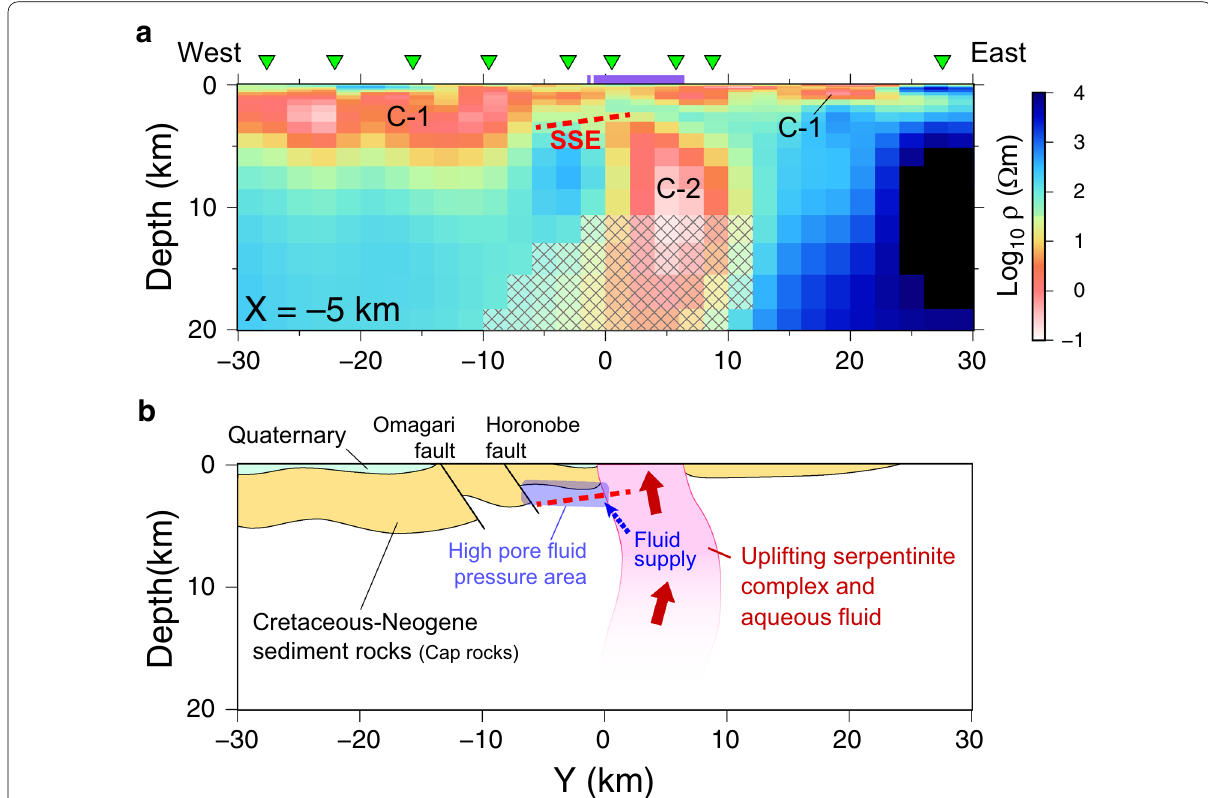
Fig. 5 a West–east cross-section at X – 5 km for the inverted model. The cross-hatched area shows the low-sensitivity area within the C-2 = anomaly. The red dashed line marks the SSE fault plane inferred by Ohzono et al. (2015). The other symbols are the same as in Fig. 3. b Geological interpretation of the inverted model at X – 5 km. The pink area with red arrows represents the uplifting serpentinite complex and associated = fluids, and includes the C-2 anomaly, the surface conductive area, and the high resistivity area sandwiched between